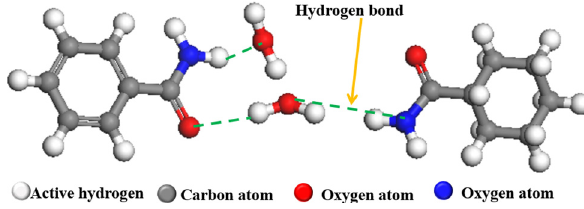
Figure 11: Intermolecular hydrogen bonding between guar gum and water